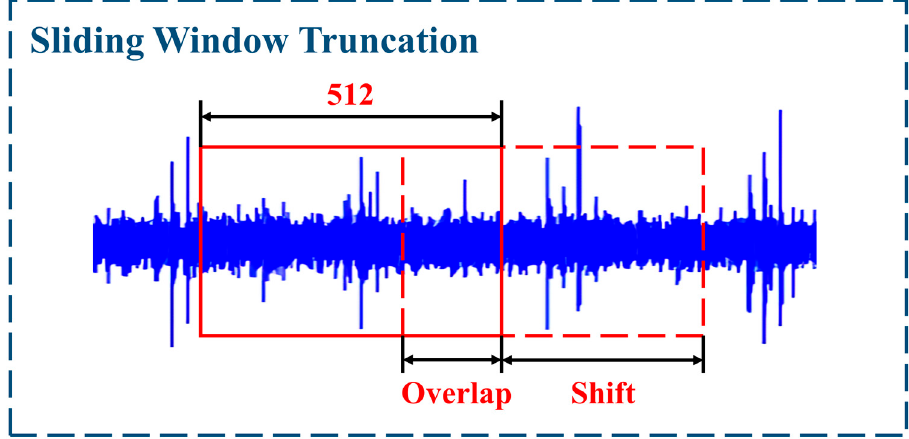
Figure 8. The sliding window truncation method.